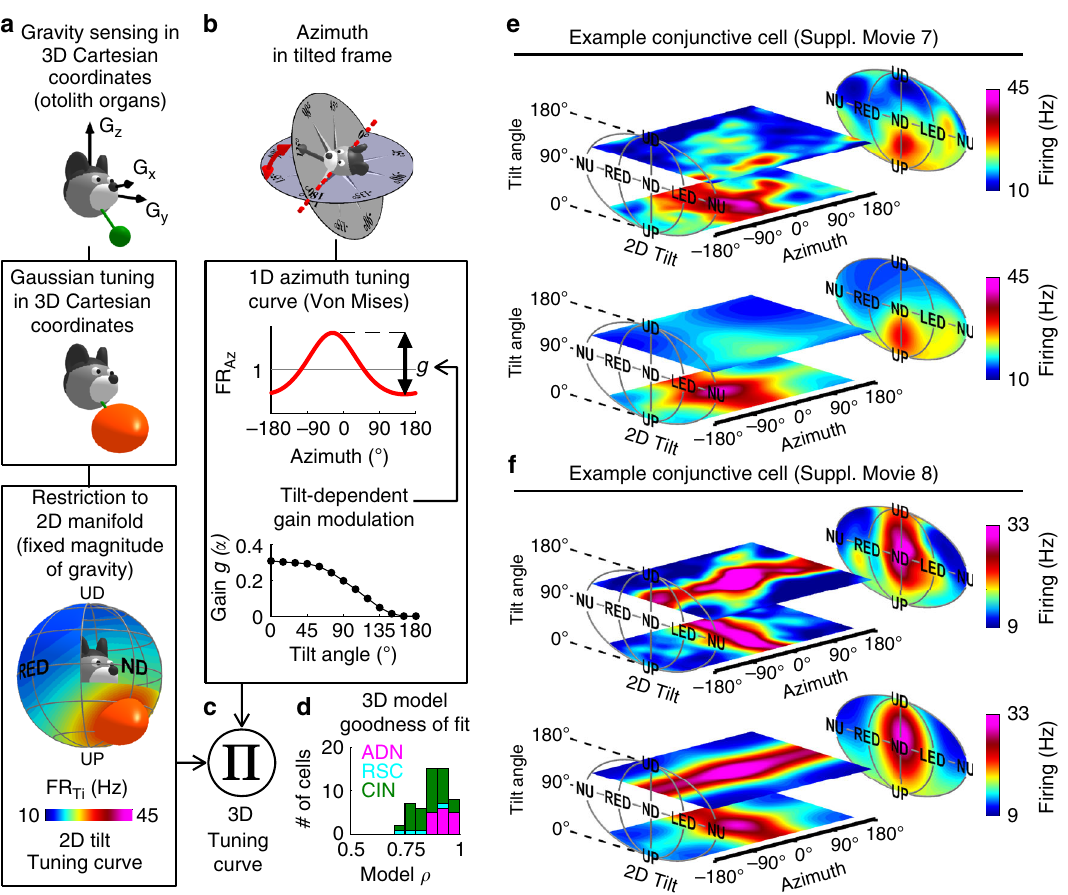
Fig. 4 Modeling 3D responses. a Modeling tilt tuning. Top: Gravity is a 3D vector (green) sensed in egocentric Cartesian coordinates by the otolith organs. Middle: to model tilt tuning, we fi rst assume a 3D Gaussian function (orange ellipsoid) in this Cartesian space. Bottom: on earth, the magnitude of gravity is constant. Therefore, we restrict the tilt tuning curve to a 2D sphere surrounding the head, which corresponds to the egocentric gravity vector experienced when tilting on earth. b Modeling azimuth tuning. Azimuth is expressed in a TA frame (top), and tuning is modeled as a von Mises distribution combined with a tilt-dependent gain factor (Fig. 3g). c 3D tuning de fi ned by the product of these two curves. d Distribution of the model ’ s coef fi cient of correlation ( ρ ) across areas. e , f Experimentally measured 3D tuning curves (top) from two conjunctive cells that maintain their azimuth tuning in the rotator and fi tted tuning curves (bottom), represented as color maps in 3D space (animated in Supplementary Movies 8, 9). The cell is e is the same as in a , b . Source data are provided as a Source Data fi